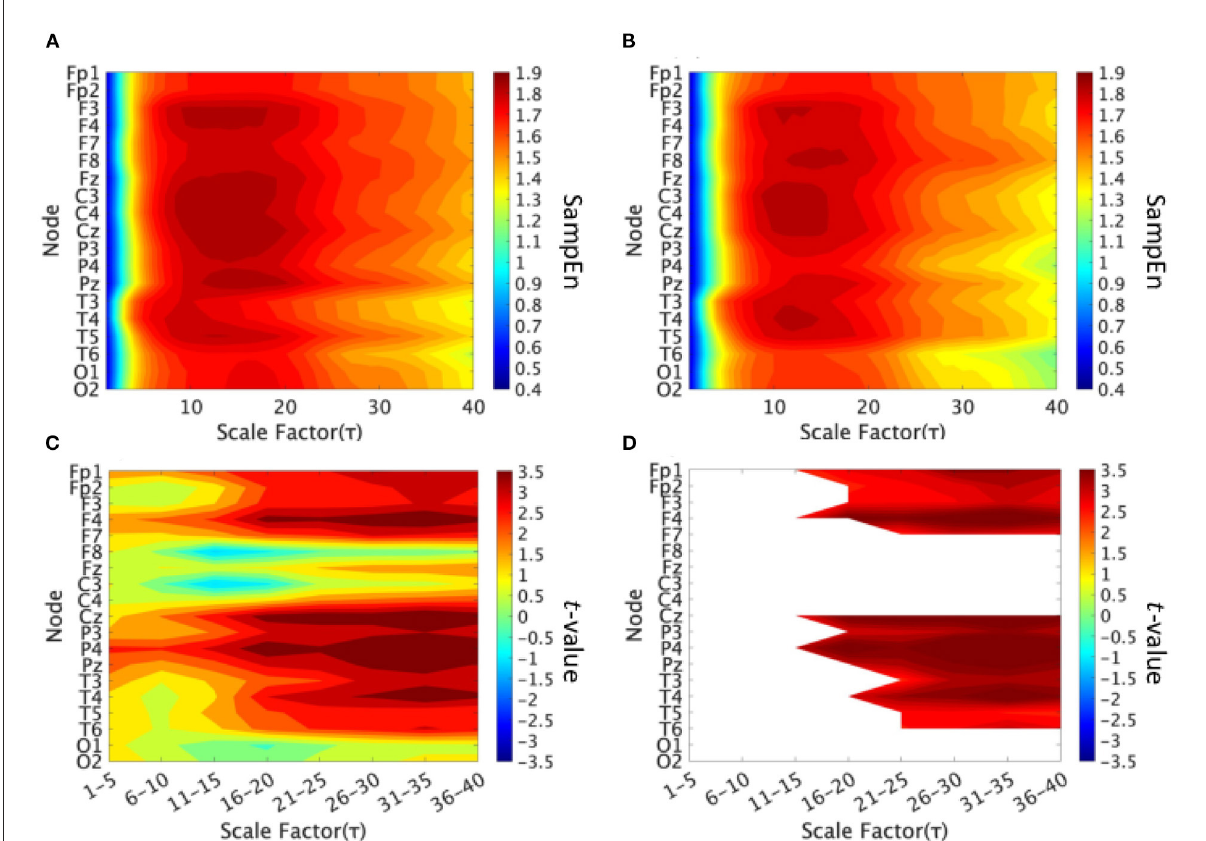
FIGURE2 Multi-scale entropy analysis in the high and low cognitive function groups. The horizontal axis represents the temporal-scale factor τ . (A) Mean values of sample entropy (SampEn) from scale factors 1 (0.005 s) to 40 (0.2 s) in the high cognitive function group. (B) Mean values of SampEn from scale factors 1 (0.005 s) to 40 (0.2 s) in the low cognitive function group. (C) t -value between the high and low cognitive function groups. The warm (cold) color represents a higher (smaller) SampEn value for the high cognitive function group compared to that of the low cognitive function group. (D) The t -value satisfying the FDR correction criteria q < 0.05 corresponding to ( p < 0.002). A significantly higher SampEn of the high cognitive function group was confirmed at slow time scale regions 11–40 (55–200